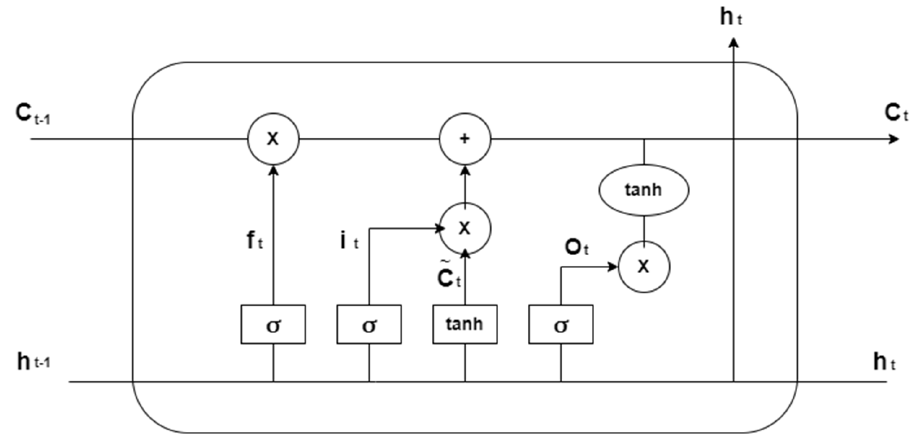
Figure 2. LSTM cell .